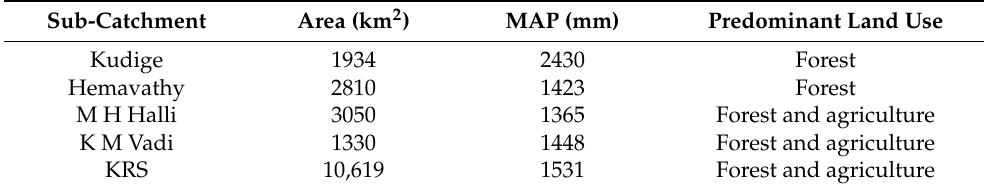
Figure 1. The location of the five catchments, outlets of the five catchments analysed in this study and three major reservoirs within the Upper Cauvery catchment. Inset 1: The location of the greater Cauvery catchment and the Upper Cauvery catchment within Peninsula India. Inset 2: A river flow diagram of the Upper Cauvery to demonstrate the flow path through gauging stations and reservoirs. Table 1. The area (km 2 ), mean annual precipitation (MAP) in mm and the predominant land use of each sub-catchment.